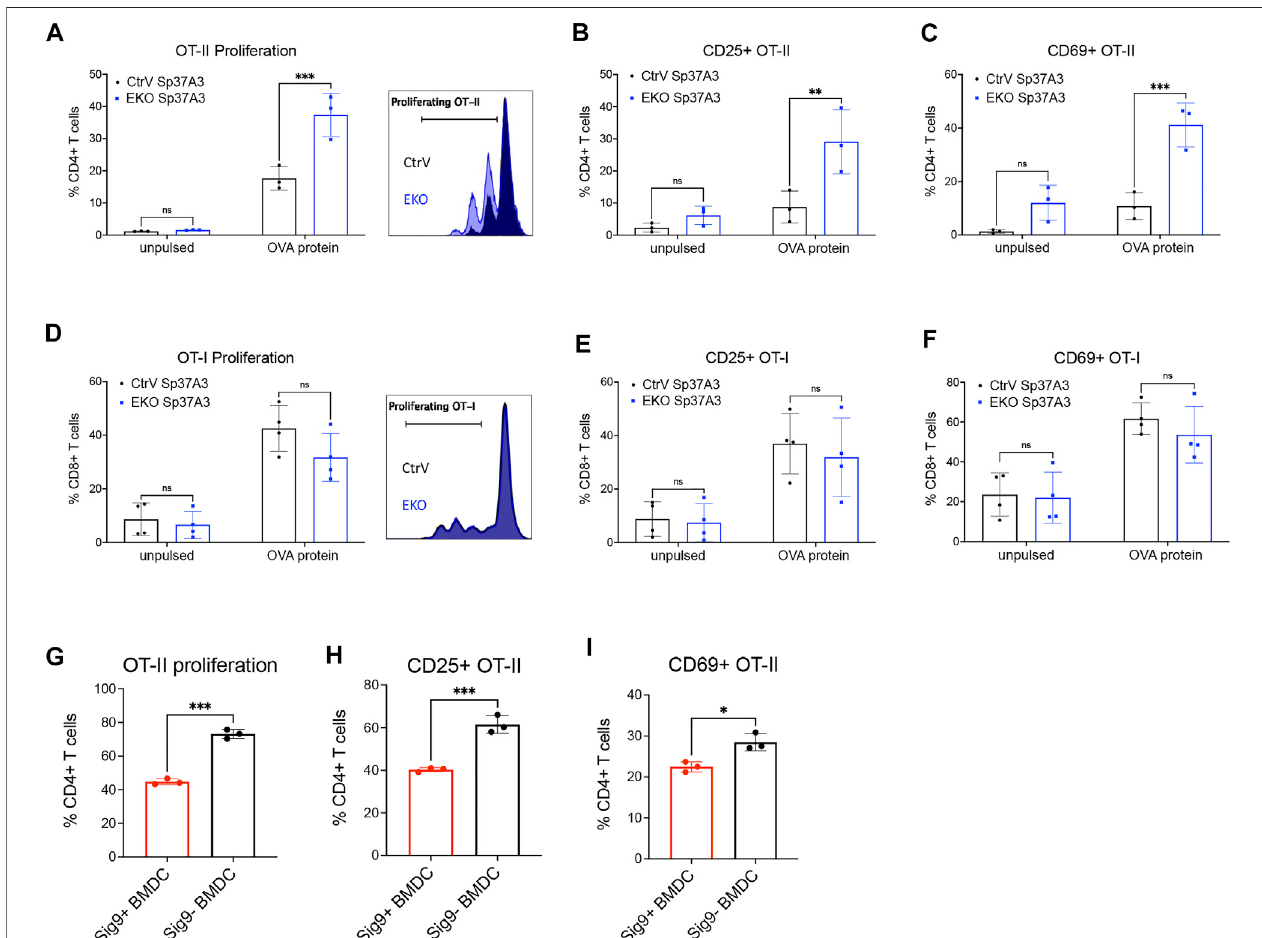
FIGURE 5 | Inhibitory Siglecs impair DC antigen presentation to CD4 + T cells. (A – F) 48-h in vitro co-culture of OVA-pulsed CtrV or EKO Sp37A3 cells with (A – C) CD4 + OT-II T cells or (D – F) CD8 + OT-I T cells. Data was pooled from several independent experiments, and each datapoint represents the average of the technical replicatesinindividualexperiments. (G – I) 72-h invitro co-cultureofOVA-pulsedSiglec-9-positive(red) orSiglec-9-negative (black)BMDCswithCD4 + OT-IITcells.Data are presented as mean (±SD). Two-way ANOVA was used for two-way comparisons, and unpaired t test was used for one-way comparisons (* p < 0.0332, ** p < 0.0021, *** p < 0.0002, and **** p < 0.0001).